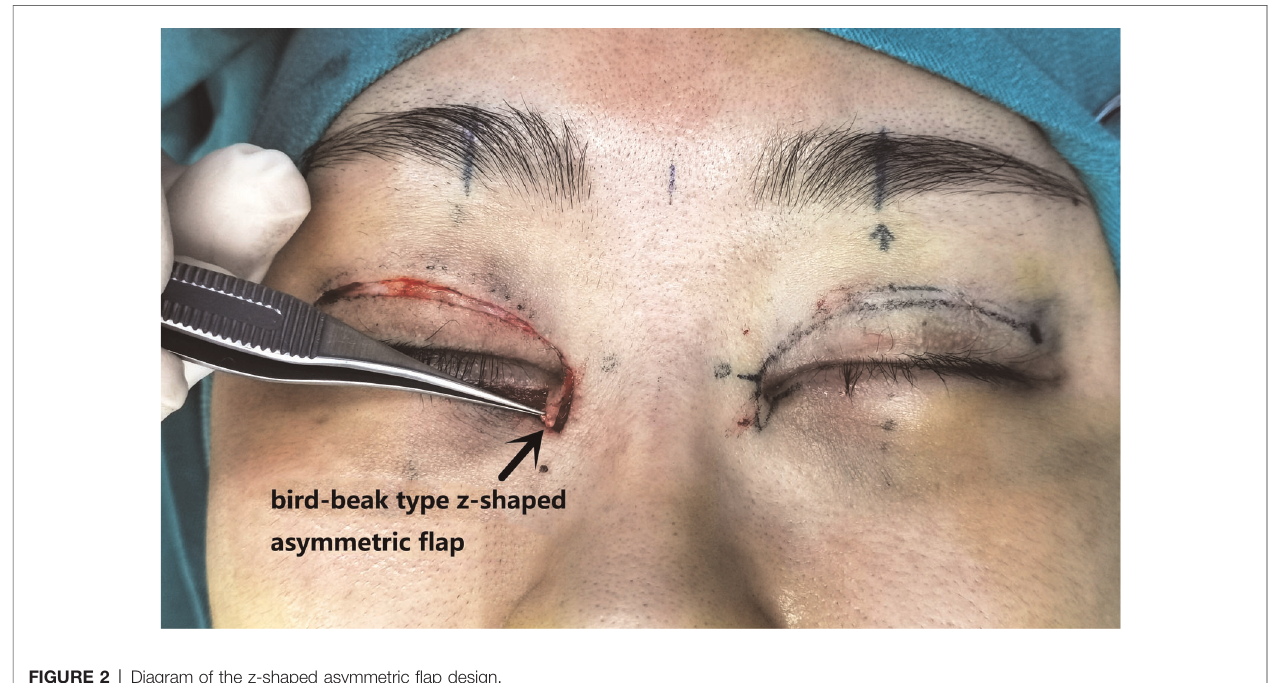
FIGURE 2 | Diagram of the z-shaped asymmetric fl ap design.